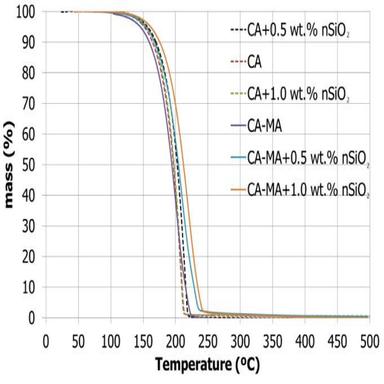
NEPCM thermogram: wt.% mass as function of temperature.